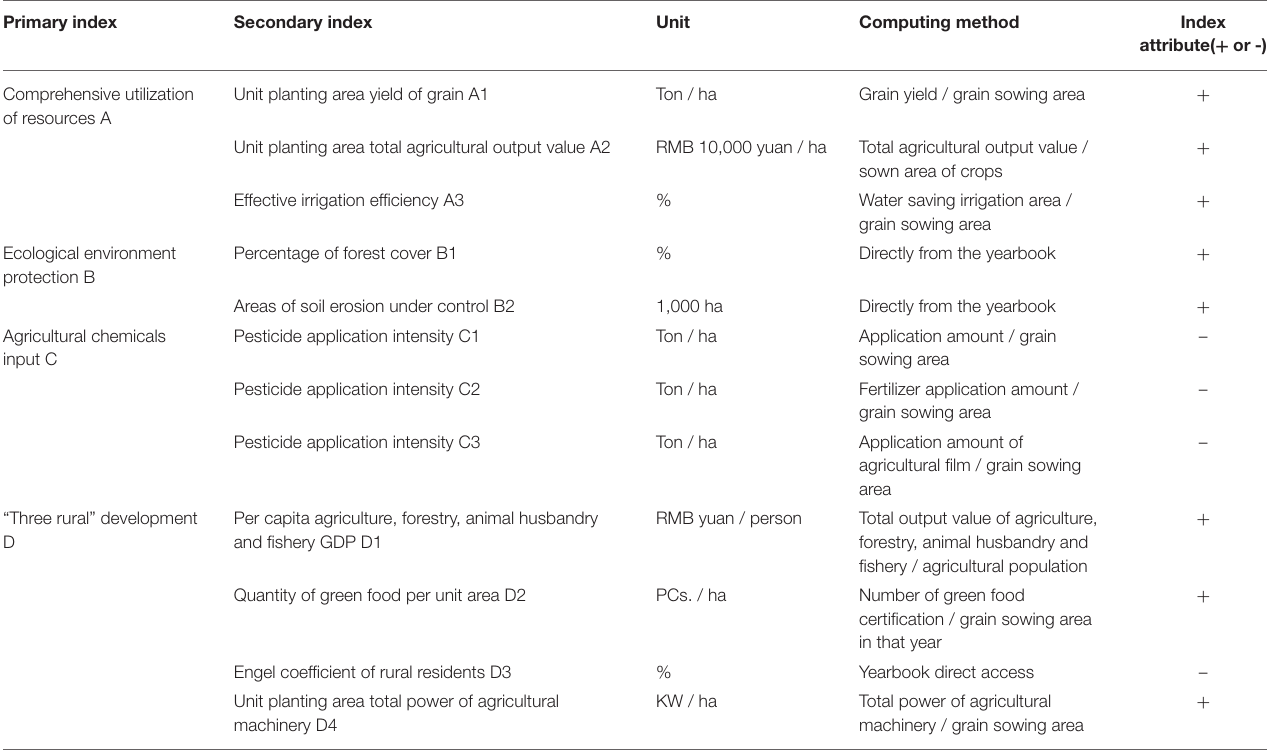
TABLE 1 | The evaluation index system of agricultural green development